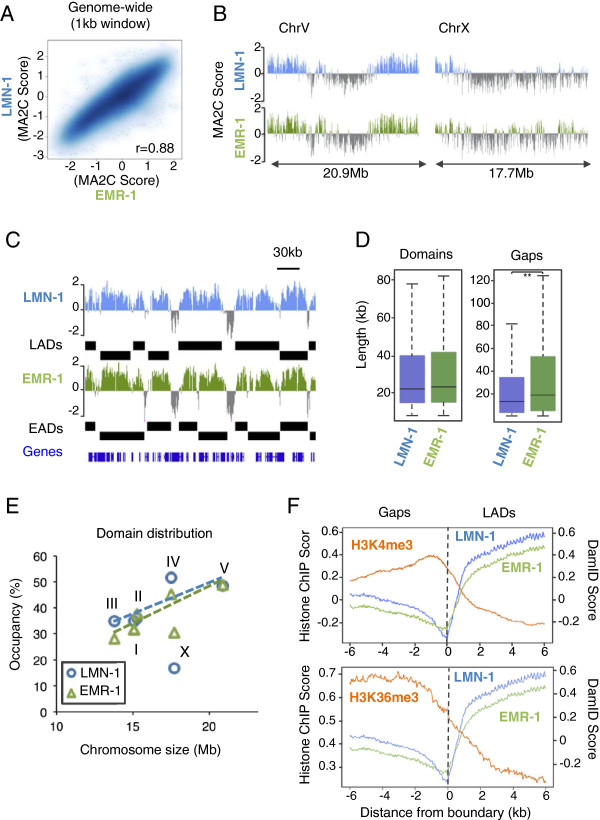
LMN-1 and EMR-1 have overlapping DNA association profiles devoid of active chromatin marks. (A) Genome-wide correlation plot of LMN-1 and EMR-1 occupancy. The correlation coefficient (r) is at the lower right corner. (B) Regions enriched for Dam::LMN-1 and Dam::EMR-1 in chromosomes V and X. For each track, the average MA2C score probe signal of three independent biological replicates is plotted. Other chromosomes are shown in Figure S3 in Additional file 1. (C) Representative region enriched for LMN-1 (MA2C score; blue) and EMR-1 (MA2C score; green) association. Positions of annotated genes are indicated below. LMN-1 and EMR-1-associated domains (LADs and EADs, respectively; black bars) were defined by a sliding window algorithm. (D) Sizes of LADs, EADs and regions between domains (Gaps). Bottom and top of boxes indicate the 25th and 75th percentiles, respectively, and lines in the boxes indicate medians. Whiskers indicate the lowest or the highest data point within 1.5× interquartile range from the box. Probability value from Wilcoxon rank sum test is indicated: **P < 10-4. (E) Relationship between chromosome size and LMN-1 or EMR-1 relative occupancy (sum of DamID domains divided by chromosome size). Linear regression lines for LMN-1 (blue; r = 0.82) and EMR-1 (green; r = 0.93) occupancy on autosomes are indicated. (F) Average H3K4me3 and H3K36me3 profiles at EAD boundaries. Chromatin immunoprecipitation (ChIP)-chip probe signal scores for indicated histone modifications are plotted. For comparison, averages of LMN-1 and EMR-1 DamID MA2C score are also shown.